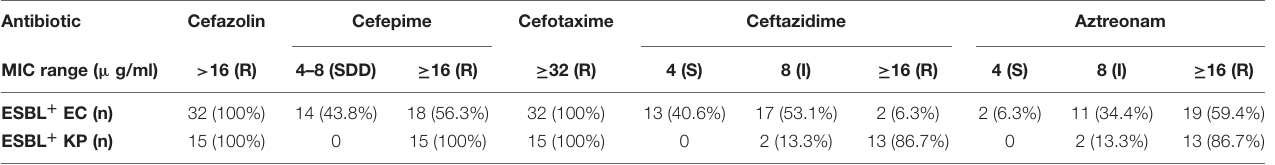
TABLE 1 | Distribution of MICs of different cephalosporins and aztreonam among the ESBL-producing isolates. Antibiotic Cefazolin Cefepime Cefotaxime Ceftazidime Aztreonam